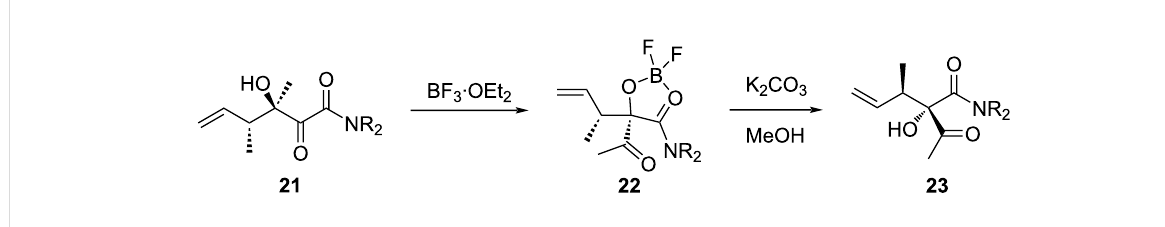
Figure 6: BF 3 -promoted diastereospecific rearrangement of α -ketol 21 to difluoroalkoxyborane 22 .